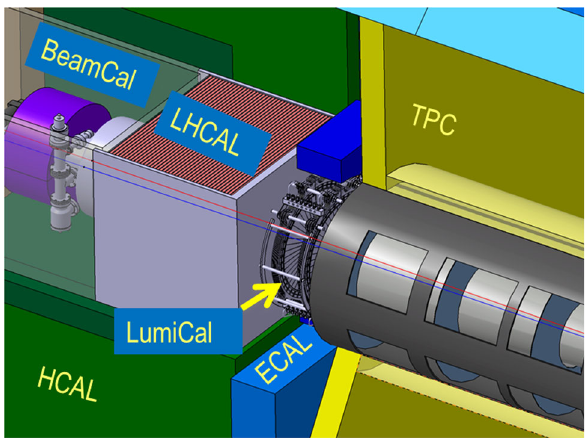
Fig. 1 The very forward region of the ILD detector. LumiCal, Beam- Cal and LHCAL are carried by the support tube for the final focusing quadrupole QD0 and the beam-pipe. TPC denotes the central tracking chamber, ECAL the electromagnetic and HCAL the hadron calorimeter